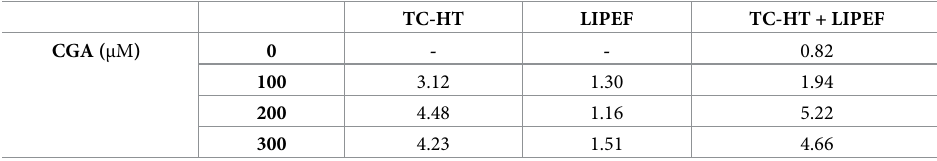
Table 1. Synergy quotient for CGA in combination with TC-HT and